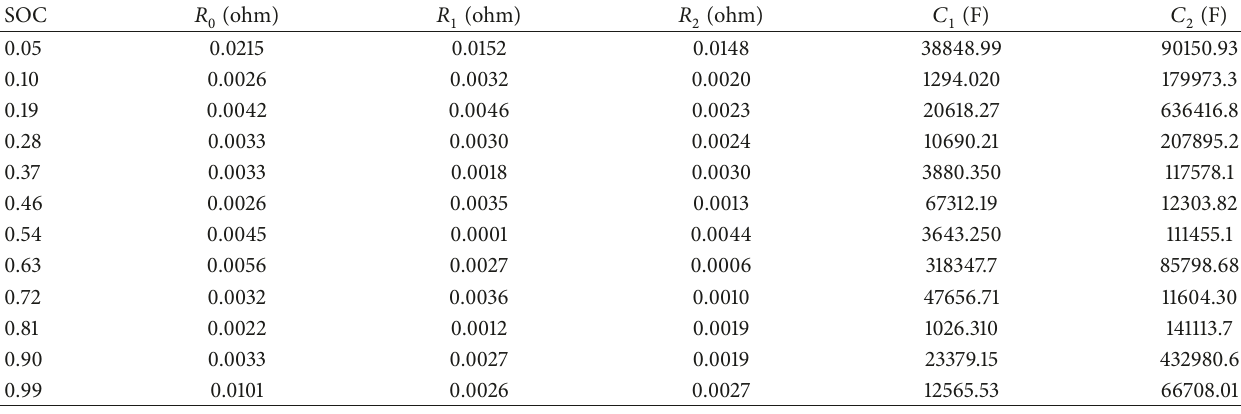
Table 1: Parameters of 2- 𝑅𝐶 equivalent circuit model.